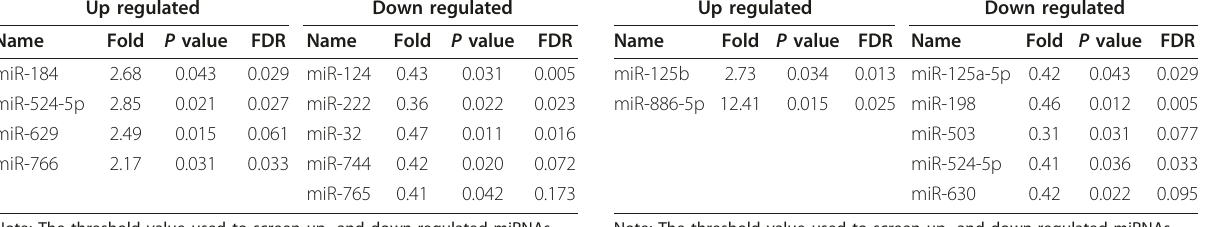
Table 4 miRNAs differentially expressed in treatment with GH responders vs. GH noresponders Up regulated Down regulated Name